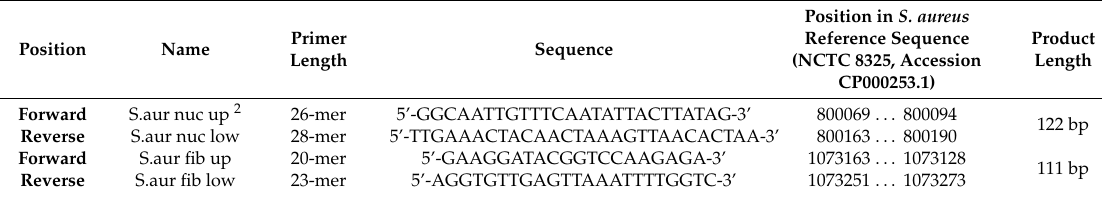
Table 1. Primer sequences for the S. aureus loci 1